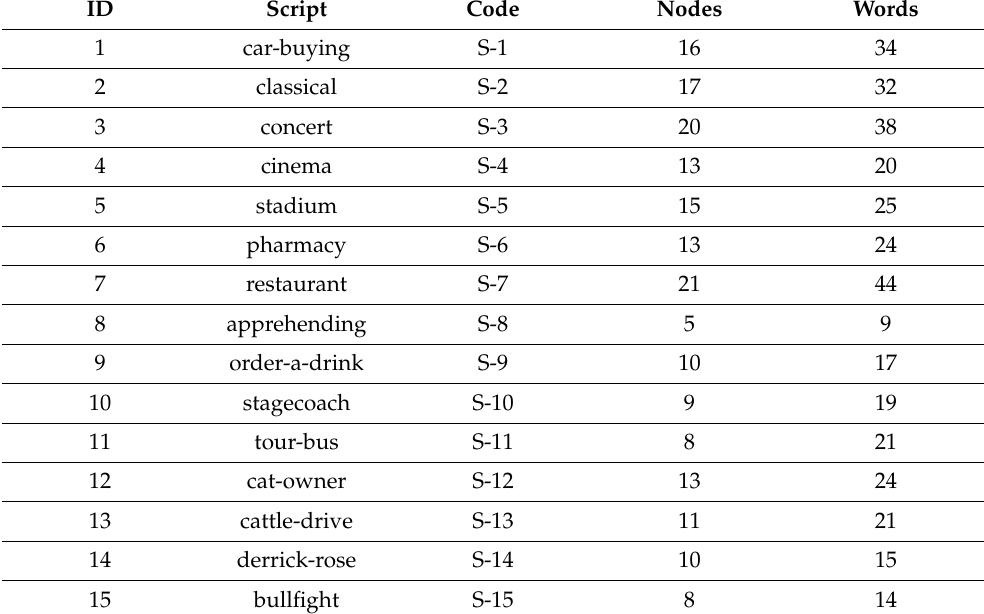
Table 2. The stored script